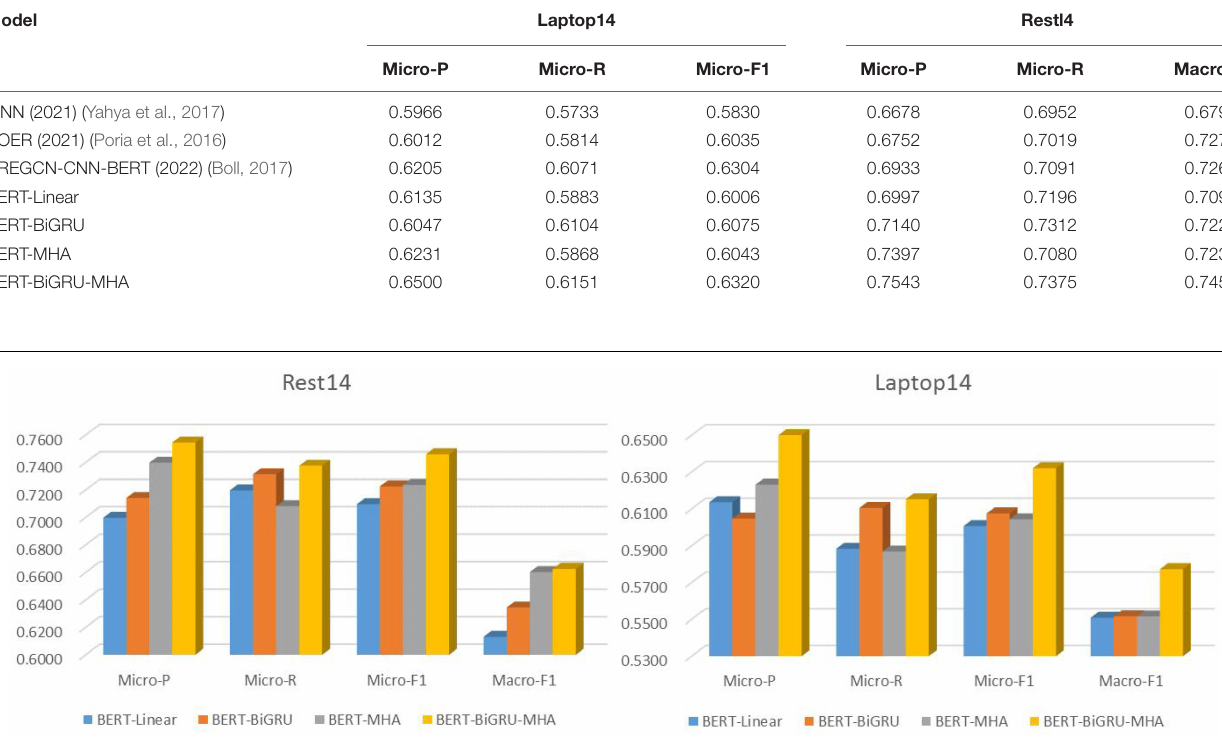
FIGURE 7 | Comparison of corresponding performance indexes of each